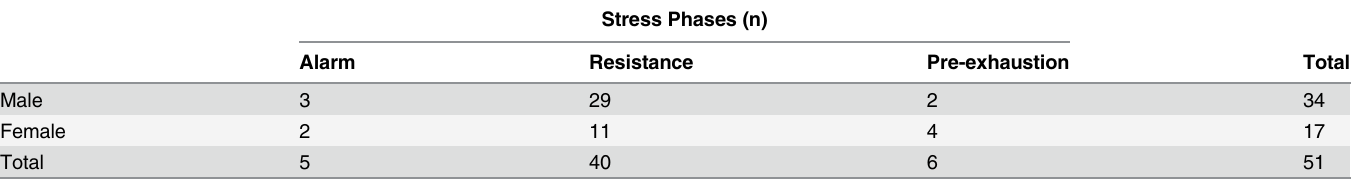
Table 3. Incidence of stress phases in business executives assessed by Lipp Inventory of Stress Symptoms for Adults (ISSL) and gender differences.